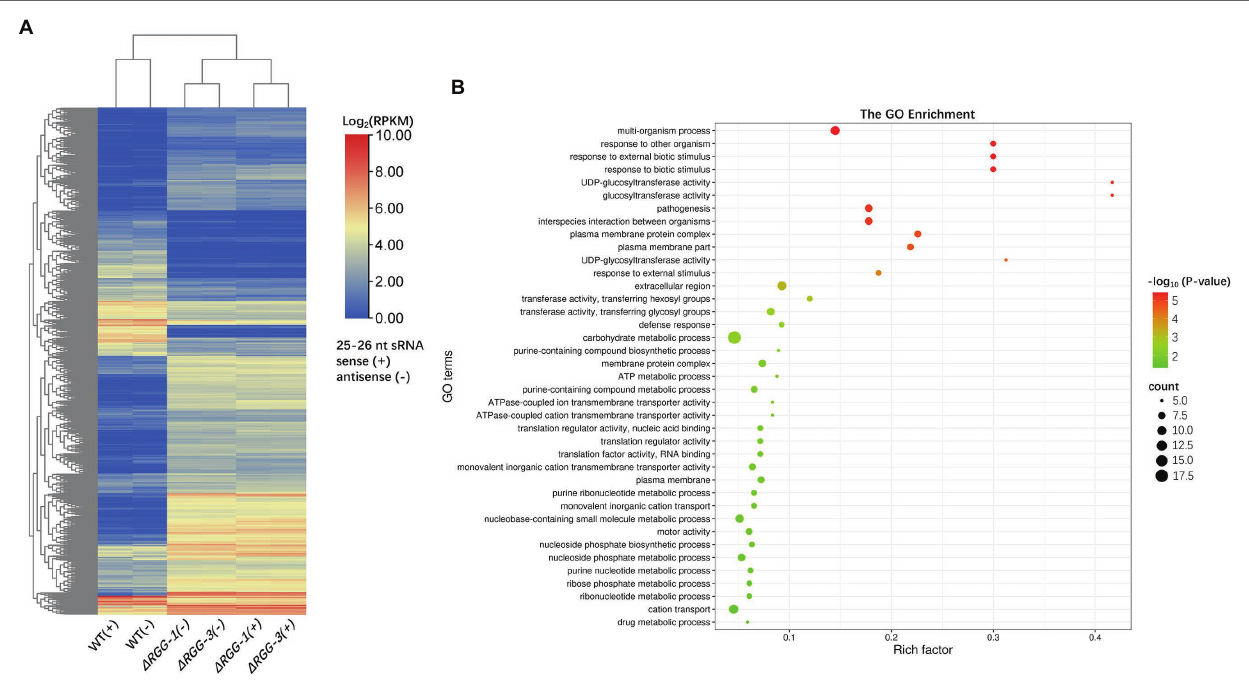
FIGURE 3 | The sRNA distribution of non-effector genes in mutants PpAGO3 Δ RGG1 and PpAGO3 Δ RGG3 . (A) Both sense (+) and antisense ( − ) strand-derived 25–26 nt sRNAs associated with 1808 non-effector genes were differentially accumulated in mutants compared to the wild-type. RPKM, Reads Per Kilobase per Million mapped reads; the heatmap color represents the transformation value of log 2 (RPKM). (B) The GO enrichment analysis for genes with which 25–26 nt sRNAs were downregulated in mutants PpAGO3 Δ RGG1 and PpAGO3 Δ RGG3 . In the bubble plot, x -axis represents the rich factor; the y -axis represents the enriched terms; the bubble size represents the enriched gene count. The larger the bubble is, the more genes enriched; the bubble color represents the enriched significance which depends on the data of –log 10 (value of p ). GO enrichment was conducted by using software Tbtools and visualized online: